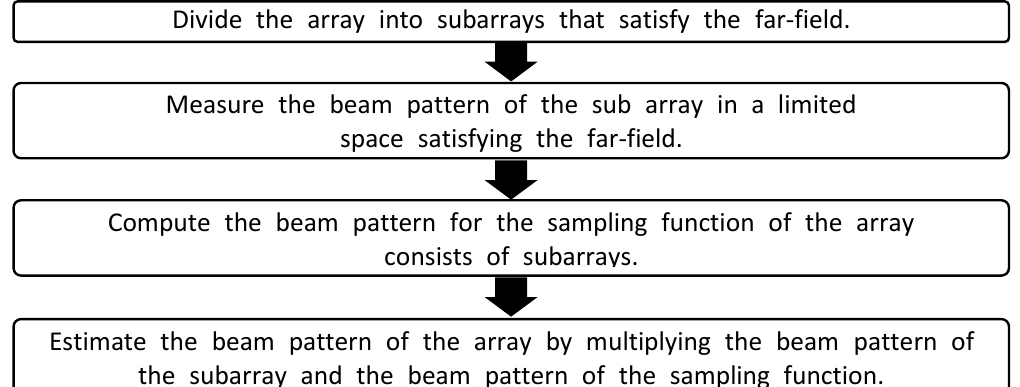
Figure 2. Flowchart of the proposed method .